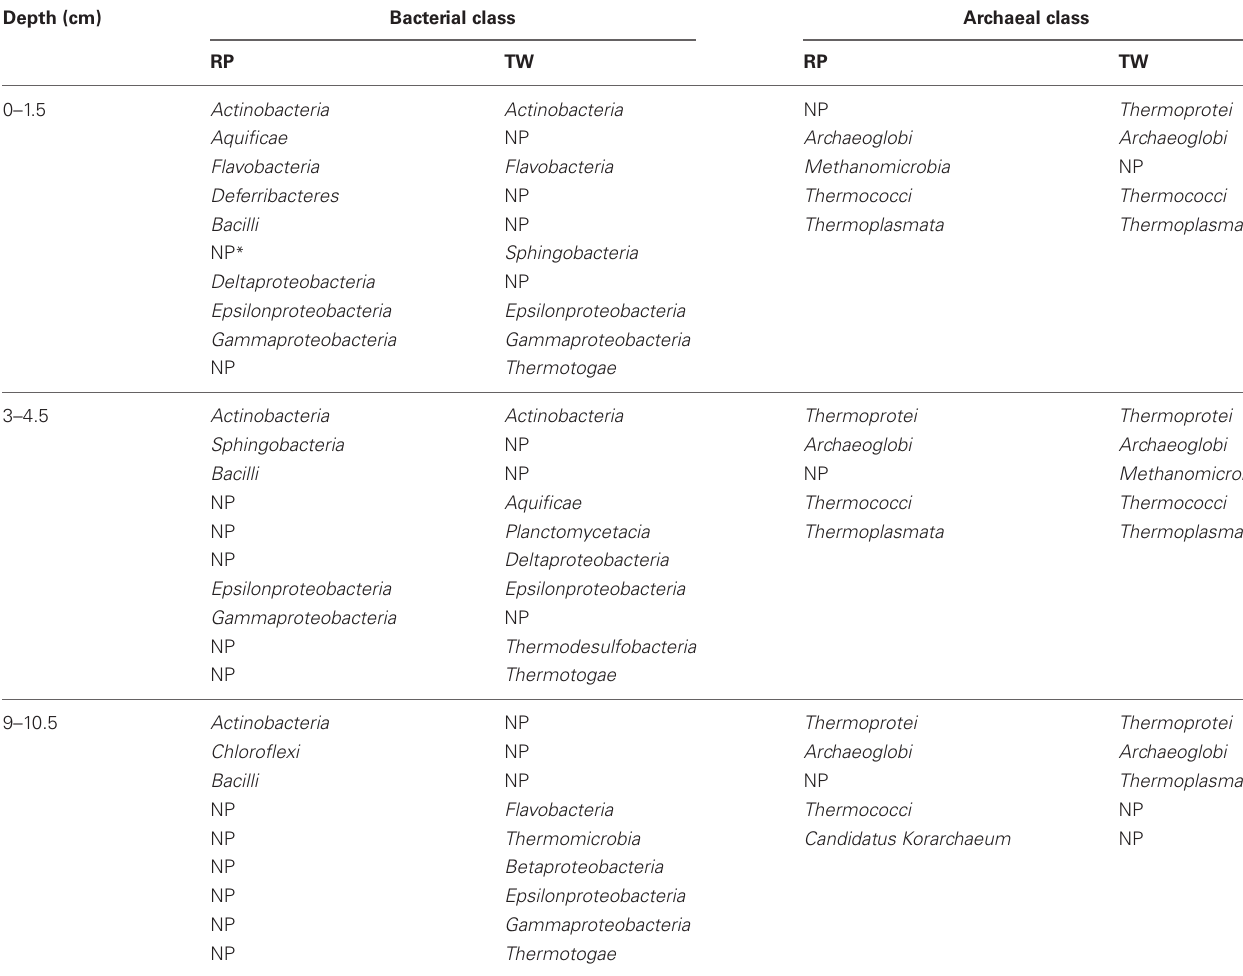
Table 4 | Bacterial and archaeal class distribution arranged by site and by depth. Depth